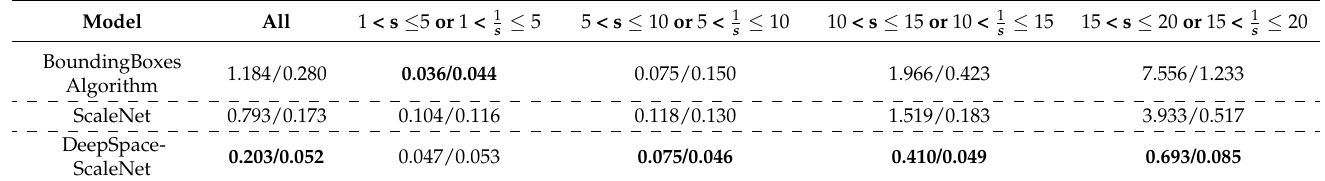
Table 2. Quantitative comparison of the average abs discrepancy and average L1 discrepancy